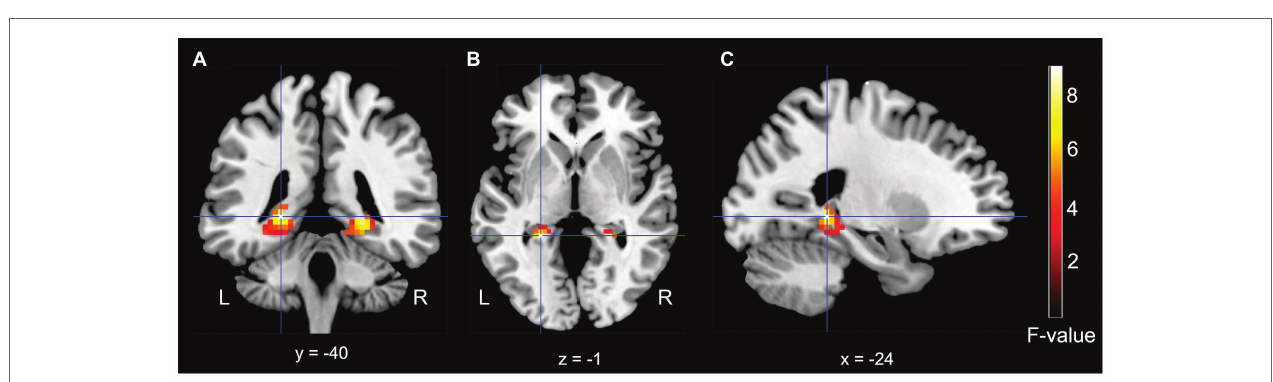
FIGURE 2 | Experiment 1 object recognition accuracy for different pairings with background scenes. (A) The hit rates and false alarms (FAs) are shown for participants responding to whether objects presented in the test phase had been presented in the previous study phase. Objects could be familiarized (blue) and non-familiarized (orange), and could be presented in intact, rearranged, and new-object/old-scene pairings. (B) Signal detection performance is indicated by D prime (d’) scores, using the corresponding new object condition, to determine the false alarm rate. Error bars indicate standard error of the mean.